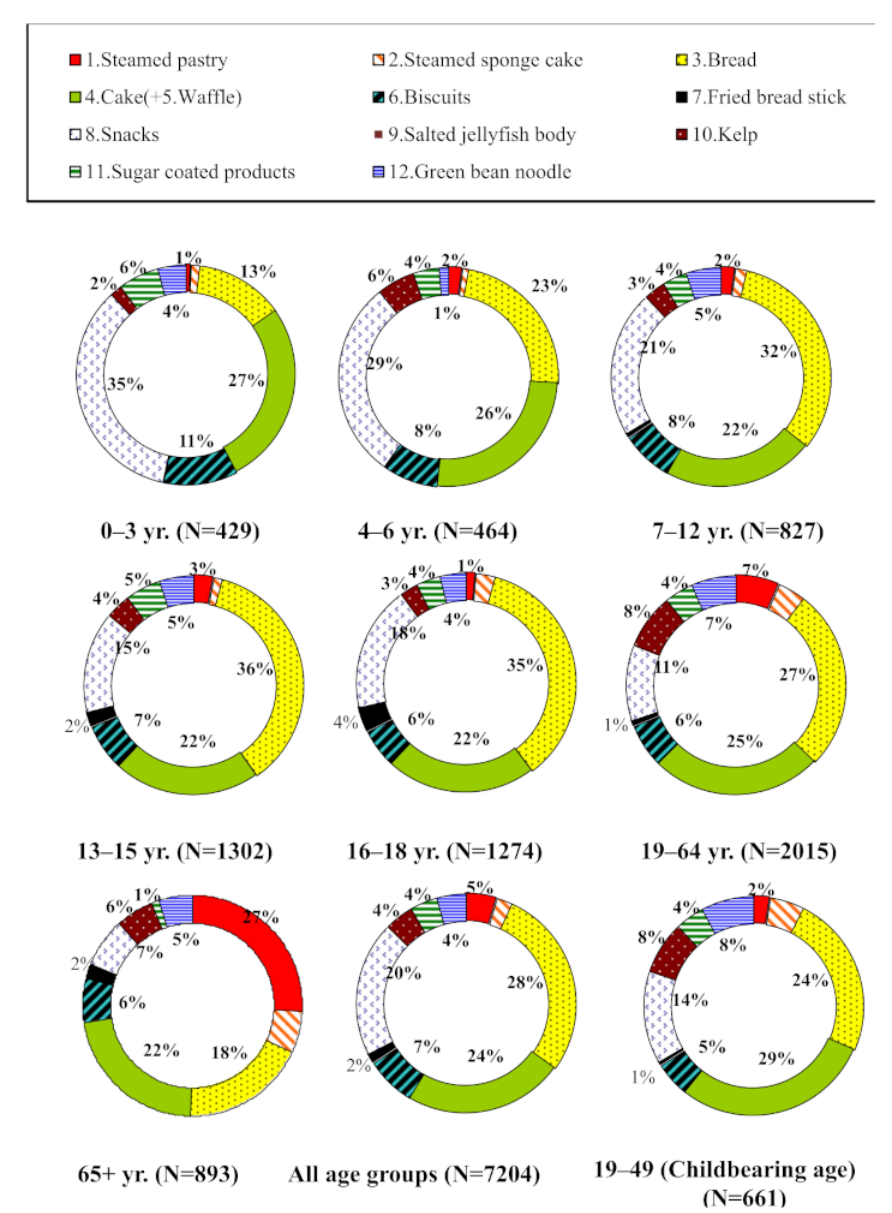
Figure 2. The contribution percentage (%) of the mean consumption rate for 12 aluminum-rich food items in specific age groups, the whole population, and women of childbearing age,